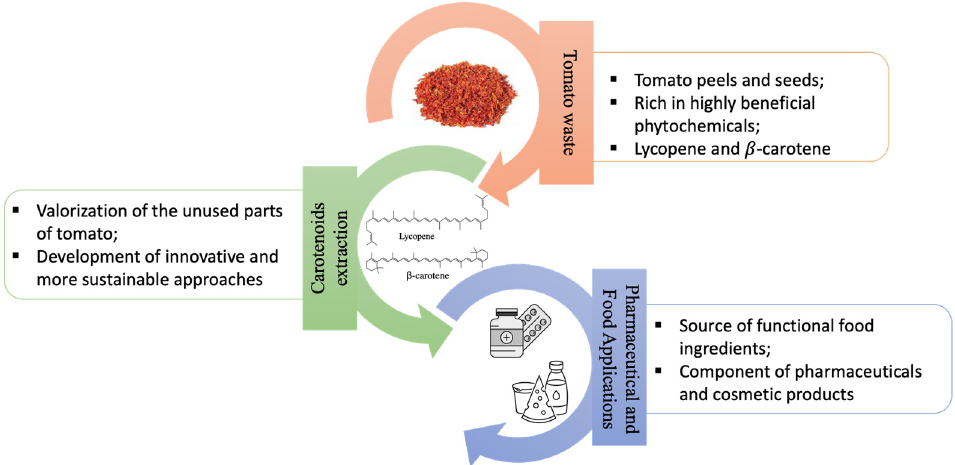
Figure 1 . Main scope of the review: carotenoid extraction procedures from tomato waste and industrial applications.